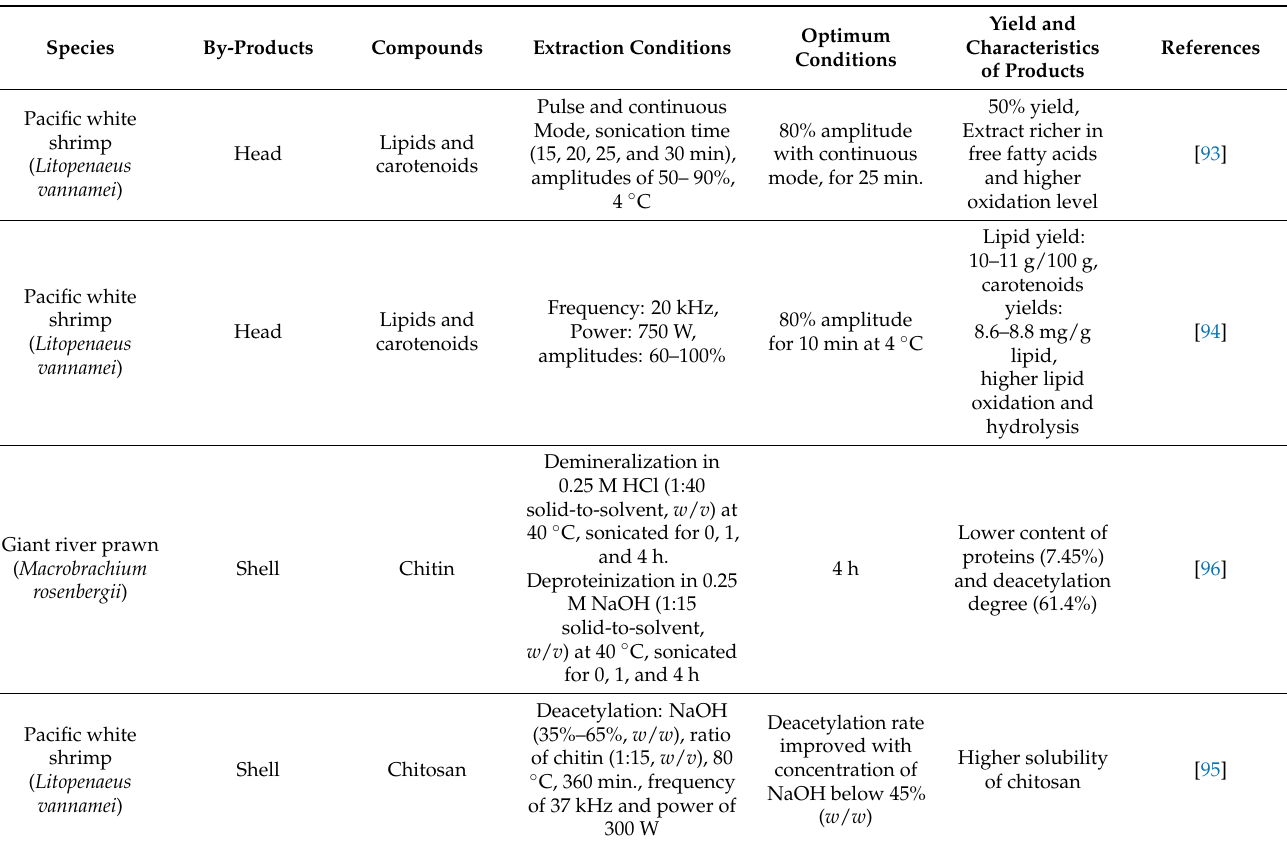
Table 3. Ultrasound-assisted extraction (UAE) of crustacean by-products for the recovery of valuable compounds. Species By-Products Compounds Extraction Conditions